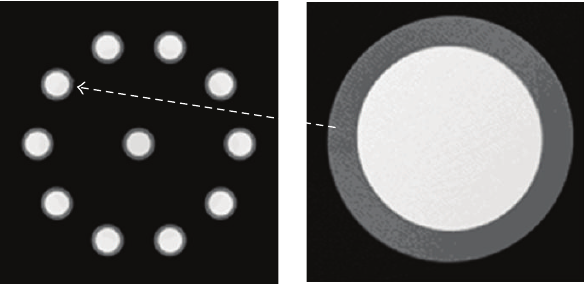
Figure 4: CT image artifacts caused by the offset of an isocenter.